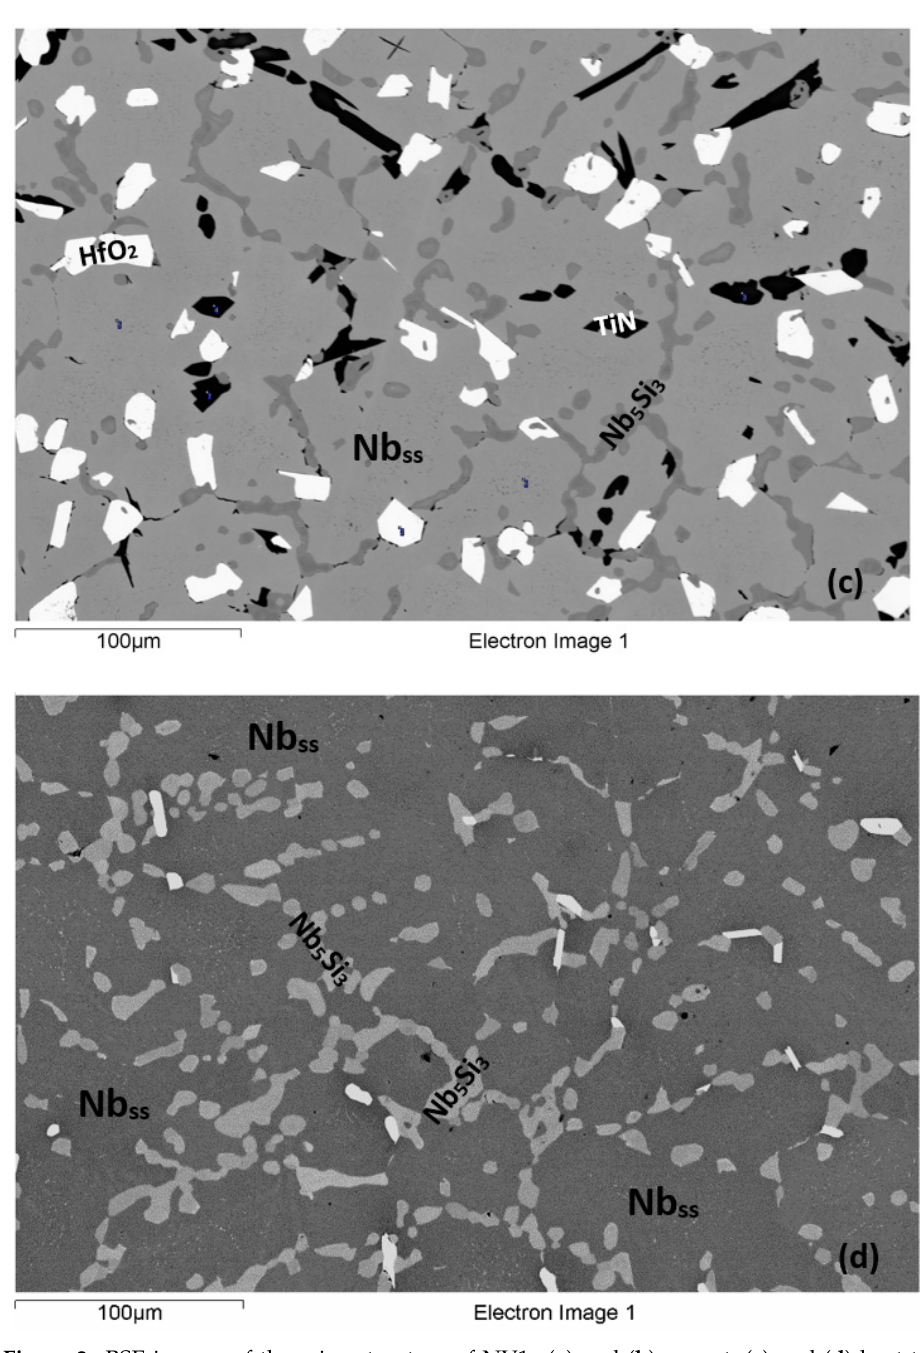
Figure 2. BSE images of the microstructure of NV1. ( a ) and ( b ) as cast; ( c ) and ( d ) heat treated. ( a ) top and ( b ) bulk of NV1-AC, ( c ) near surface area of NV1-HT, and ( d ) bulk of NV1-HT. Analysis in ( b ) as follows. 1: 5-3 silicide 35.9Nb-18.8Ti-32.1Si-4.1Al-1Cr-6Hf-0.9Sn-1.2V, Nb/(Ti + Hf) = 1.45, <Si> = 37.1 at.%, 2: 5-3 silicide 33.7Nb-19.4Ti-33.1Si-3.9Al-0.6Cr-6.5Hf-0.8Sn-2V, Nb/(Ti + Hf) = 1.30, <Si> = 37.8 at.%, 3: 5-3 silicide 33.8Nb-20.8Ti-31.9Si-3.8Al-0Cr-7Hf-0.9Sn-1.8V, Nb/(Ti + Hf) = 1.22, <Si> = 36.6 at.%.